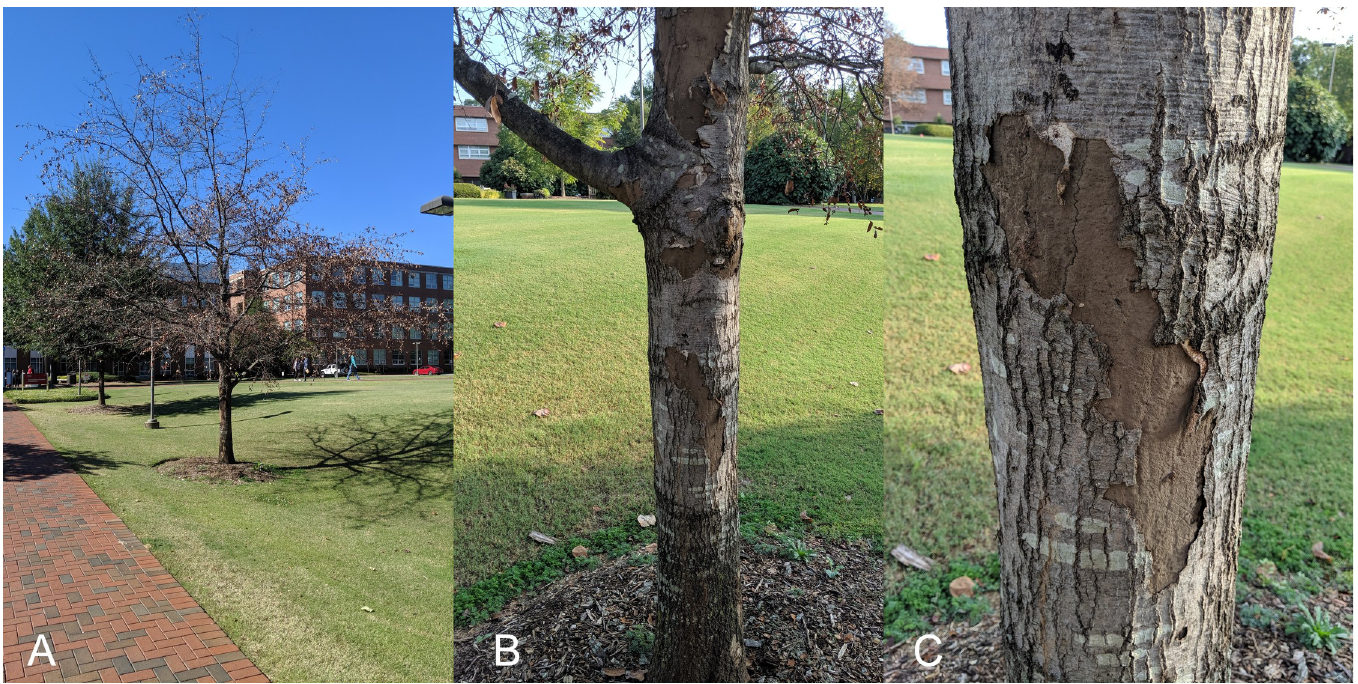
Fig 1. A: Location of the Darlington oak ( Quercus hemisphaerica W. Bartram ex Willd.) exhibiting abundant growth of the fungus Biscogniauxia atropunctata (Schwein.) Pouzar where the beetles and larvae of Laemophloeus biguttatus were collected; B&C: Images showing the growth of the fungus and peeling bark (October of 2019; photos by